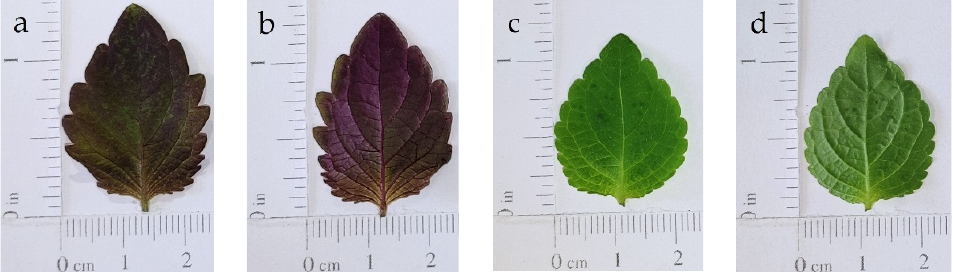
Figure 2. Leaves of microgreens of P. frutescens var. crispa ( a , b ), and var. frutescens ( c , d ). Upper leaf pages are shown in ( a , c ), lower leaf pages in ( b , d ), respectively.